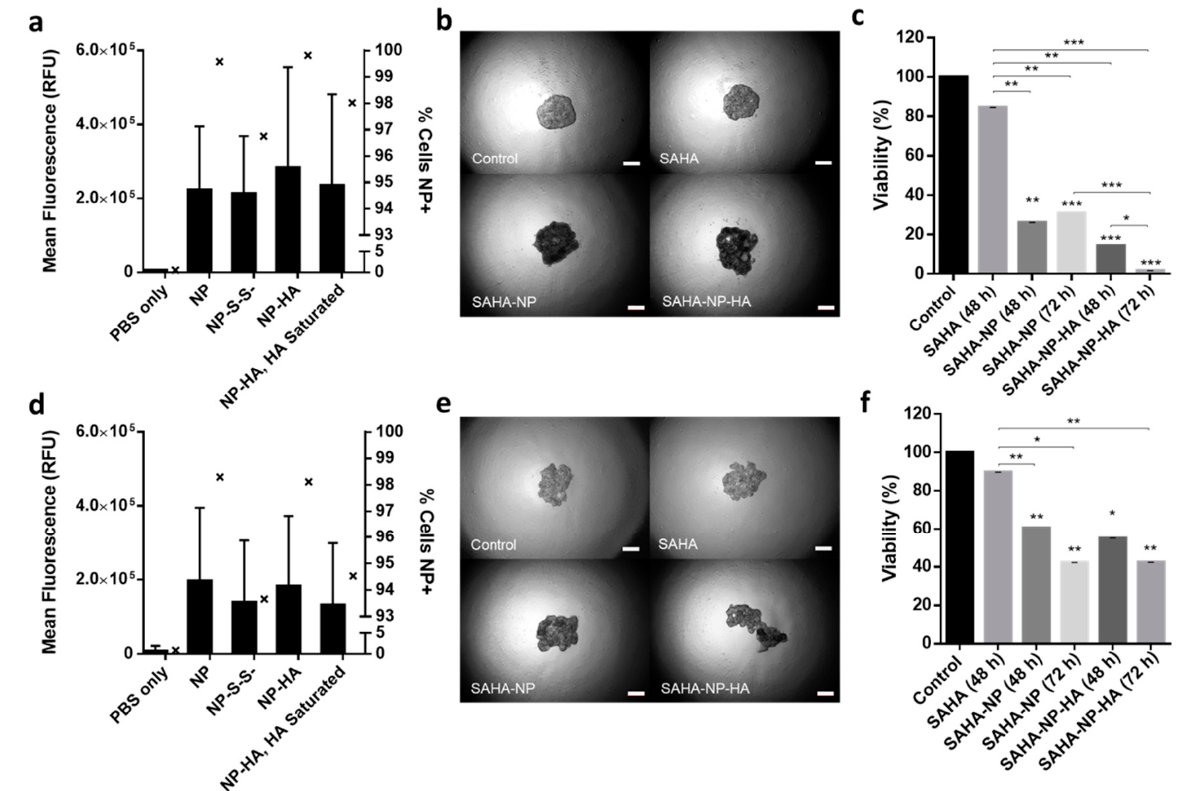
Figure 7. Nanoparticle uptake in 3D models. Quantified uptake in Ishikawa ( a ) and Hec50 ( d ) per cell, with a minimum of 5 × 10 4 cells per sample and all treatments were 2.5 µ M. Mean RFU/cell is depicted by bars which correspond to the left axis, the percentage of nanoparticle positive cells is given by interleaved scatter plots that corresponds to the right axis. Images of endometrial cancer model spheroids following treatment (40 × magnification). Images of Ishikawa ( b ) and Hec50 ( e ) control spheroids and spheroids treated with SAHA free, SAHA-NP and SAHA-NP-HA. Scale bars are 50 µ m. Cytotoxicity of SAHA-NP delivery systems. Spheroid cytotoxicity assessment using Celltiter Glo 3D ( n = 3) of SAHA Free Drug, SAHA-NP and SAHA-NP-HA at 2.5 µ M for 48 h and 72 h in Ishikawa ( c ) and Hec50 ( f ). All data is normalized to the untreated control cells. Statistical significance is indicated on graphs: p ≤ 0.05 denoted by *, p ≤ 0.01 by ** and p ≤ 0.001 by